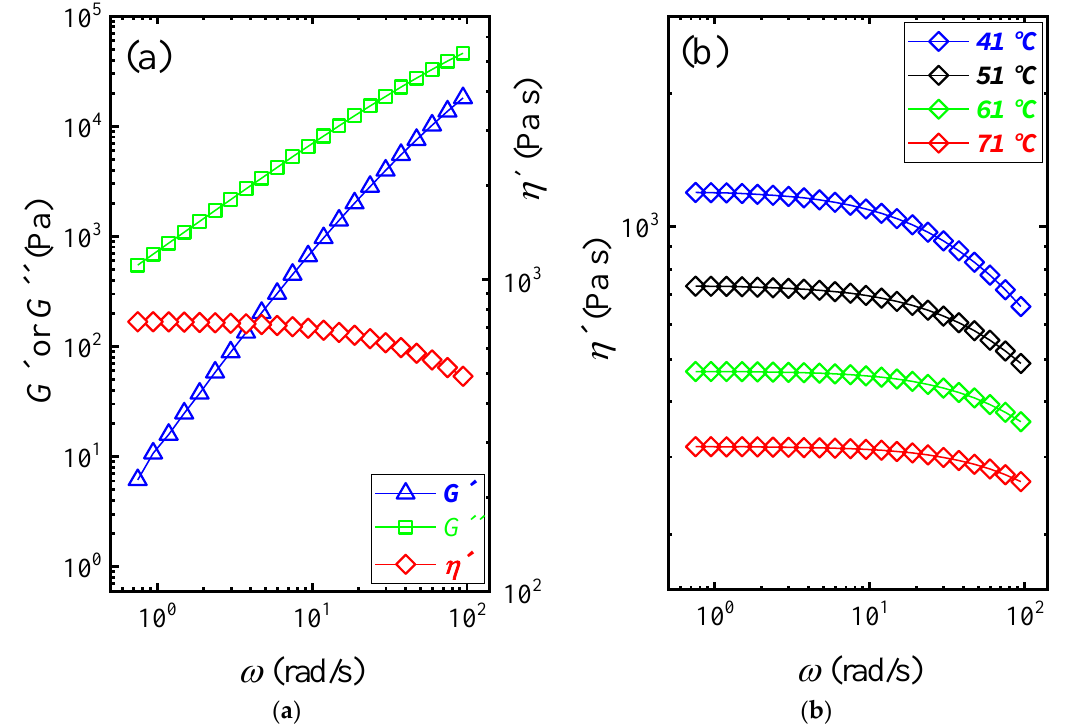
Figure 3. ( a ) Elastic and viscous moduli as a function of frequency for representative BS 15 CL 85 copolyester at 51 °C. ( b ) Real part of the complex viscosity as a function of frequency for BS 15 CL 85 copolyester obtained in a temperature range of 41 – 71 °C.